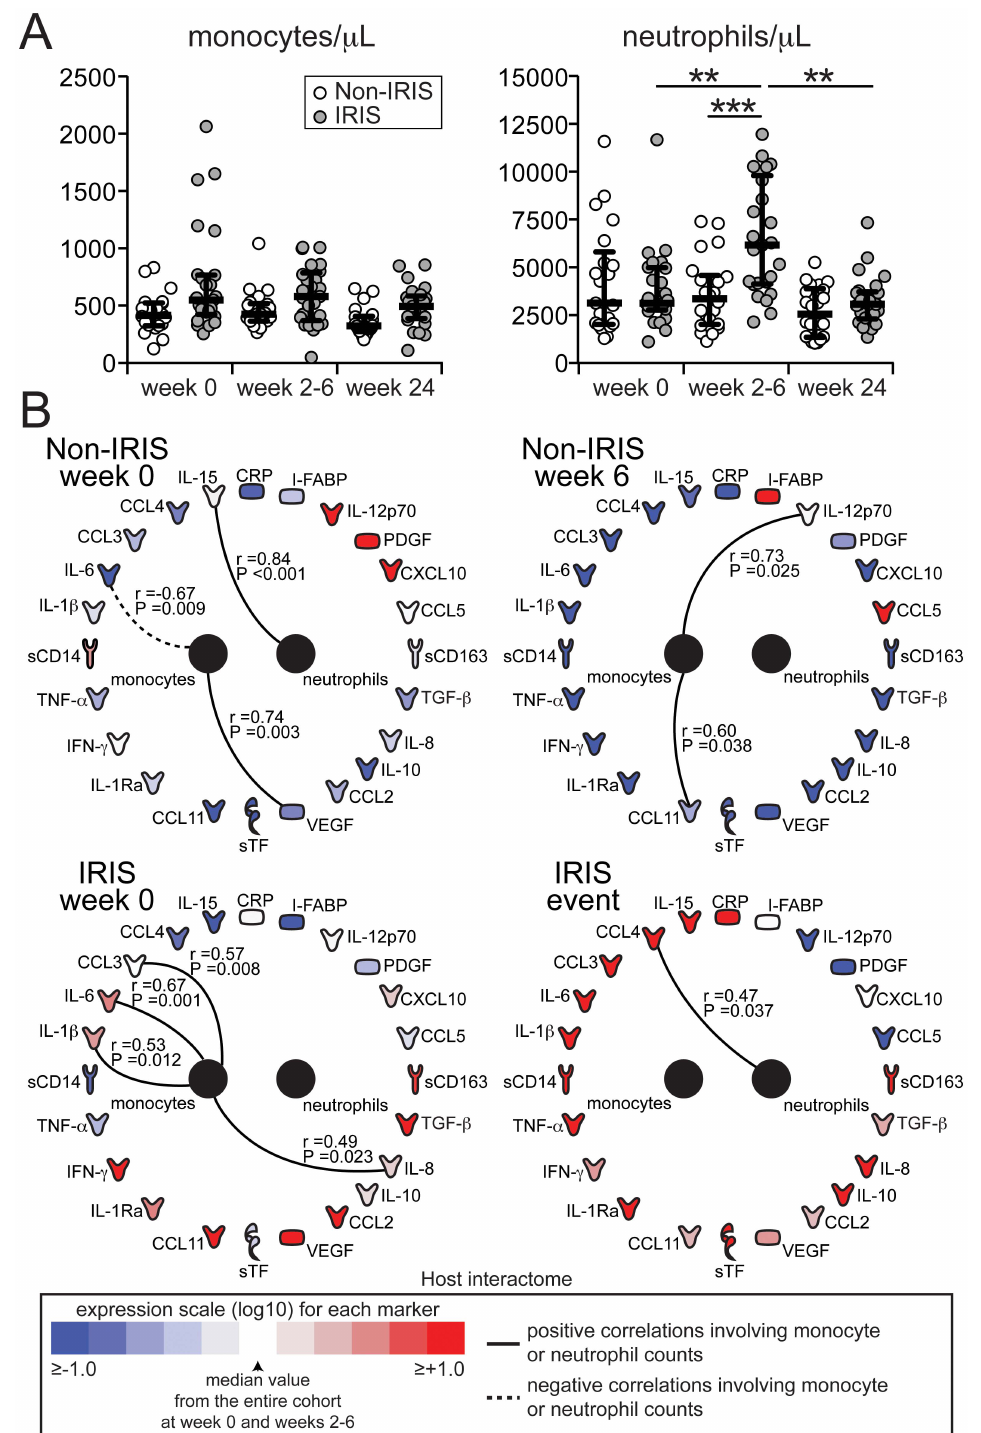
Figure 3. Circulating monocyte counts do not correlate with soluble biomarkers of inflammation and immune activation in TB-HIV co-infected individuals. ( A ) Numbers of circulating monocytes (left panel) and neutrophils (right panel) are compared at week 0 (pre-ART), at weeks 6 or at the time of IRIS, and at week 24 after ART initiation between TB-HIV co-infected patients who developed paradoxical TB-IRIS (n=26) and those who did not (n=22). Lines represent median values and interquartile ranges. Data were analyzed using the Mann-Whitney test or Wilcoxon matched-pairs test for paired comparisons within each study group. ** P , 0.01, *** P , 0.001. ( B ) The network analysis (interactome) showed statistically significant correlations (P , 0.05) between neutrophil or monocyte counts and plasma biomarkers. Associations were assessed with Spearman rank tests.